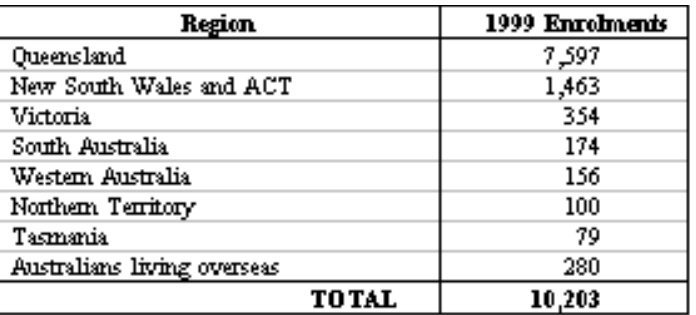
Table 2: Location/Number of USQ’s Australian Distance Education Students in 1999 (Below/End)